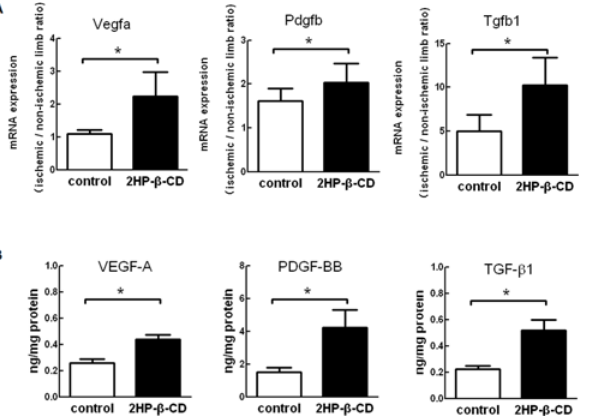
Fig 5. Angiogenesis-related mRNA and peptide expression in ischemic hindlimb muscle. (A) Expression levels of Mrna for angiogenic factors in calf muscle from 2HP- β -CD-treated (filled) and PBS- treated (open) mice at post-operative day 28 were determined by real-time PCR. GAPDH was used as an endogenous control. Data are expressed as the ratio of the values in ischemic over non-ischemic muscle and represent the mean ± S.E.M. ( n = 8 mice per group). * p < 0.05. (B) Angiogenesis-related peptide expression in calf muscle from 2HP- β -CD-treated (filled) and PBS-treated (open) mice at post-operative day 28 were determined by ELISA. Data are reported in nanograms per mg of proteins and represent the mean ± S.E.M. ( n = 6 mice per group). * p <